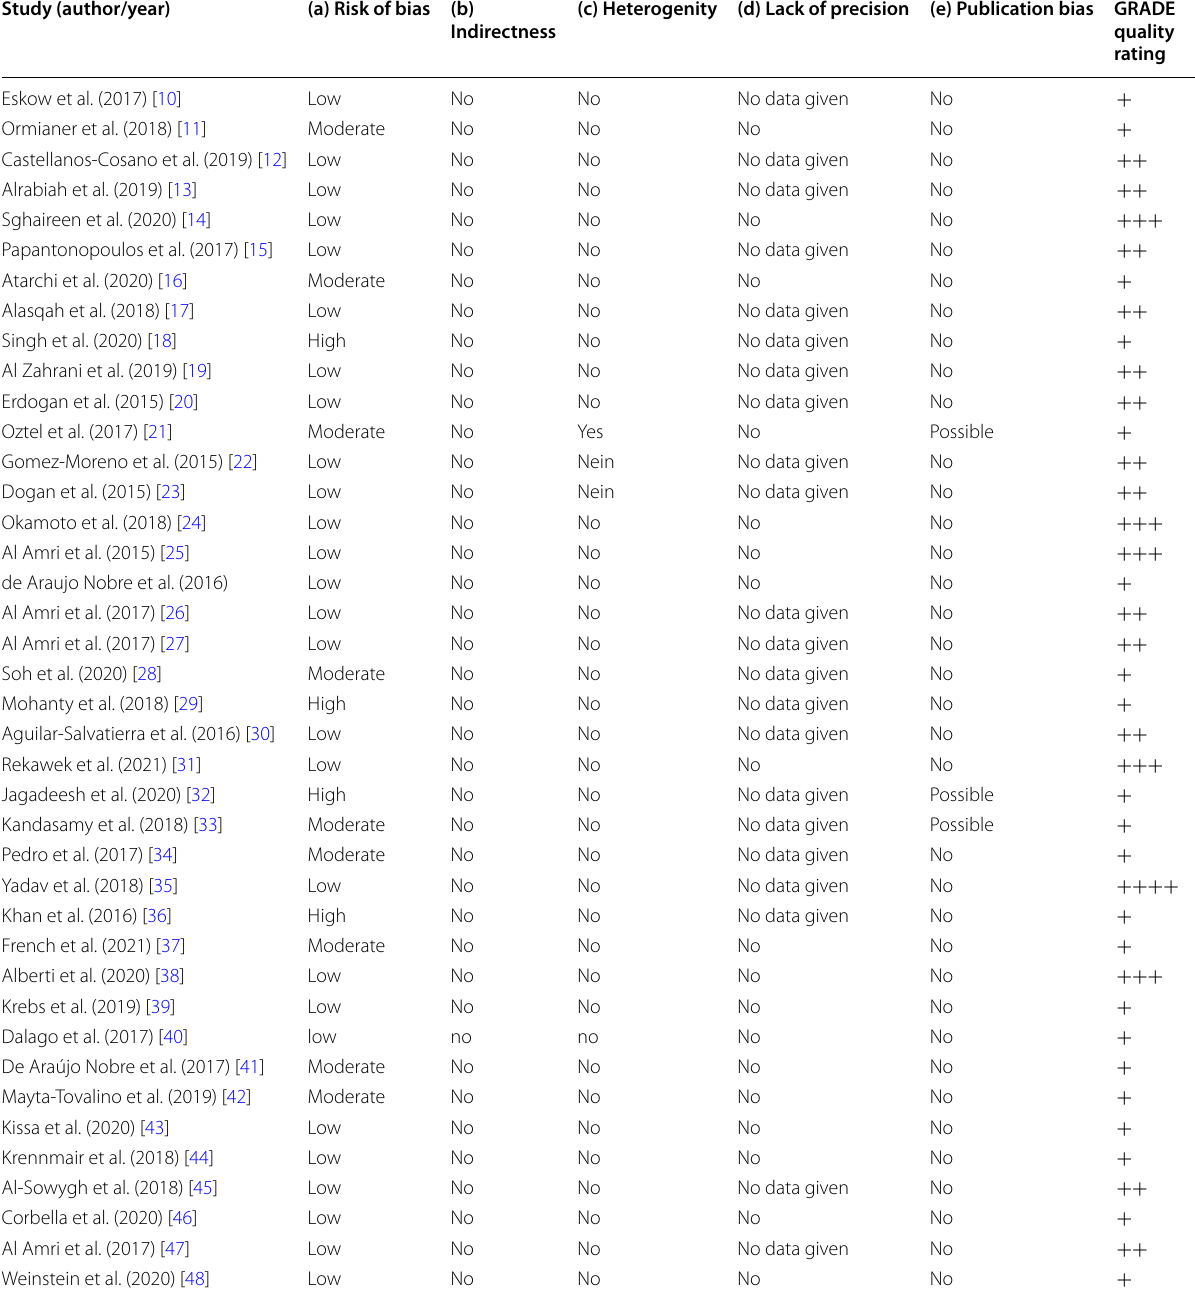
Table 3 GRADE quality rating for clinical studies Study